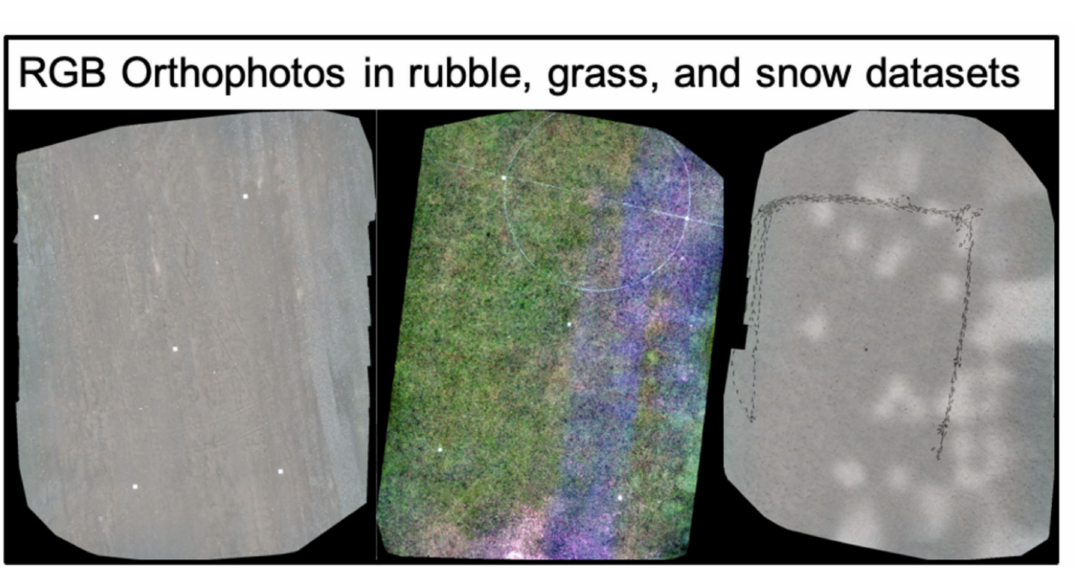
Figure 7. Generated RGB orthophotos from Pix4D Mapper for each environment.